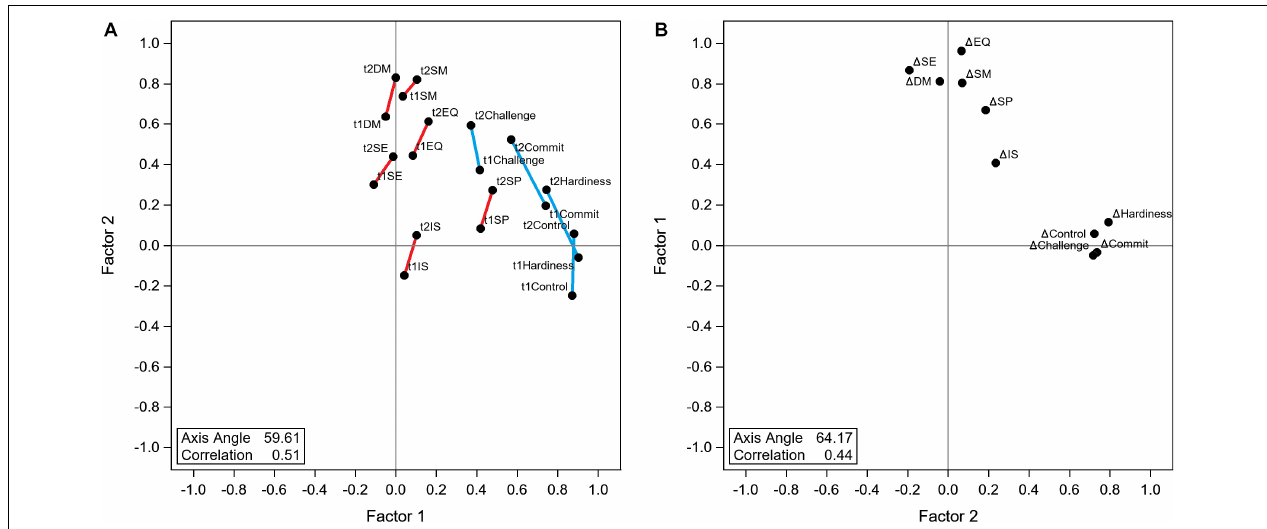
FIGURE 1 | Factor analysis loading scores of Hardiness and Emotional quotient (EQ). (A) Pre-event (t1) and Post-event (t2) loadings plot. Panel shows an Optimin rotation of factor loadings. Pre and post data point are linked by a line to help visualize their spread. Hardiness data points are linked in blue while Emotional Intelligence are linked in red. (B) Difference ( (cid:49) ) loadings plot. Panel shows an Optimin rotation of factor loadings and has axes flipped to match Panel (A) loading orientation.